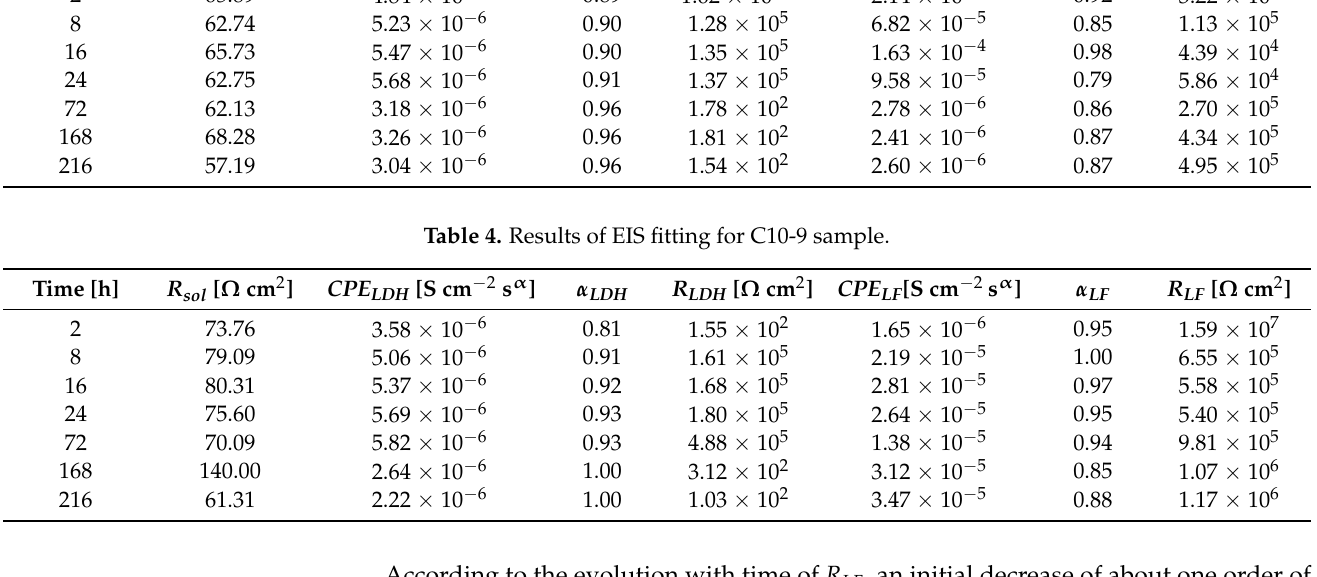
Table 3. Results of EIS fitting for C10-4.5 sample.